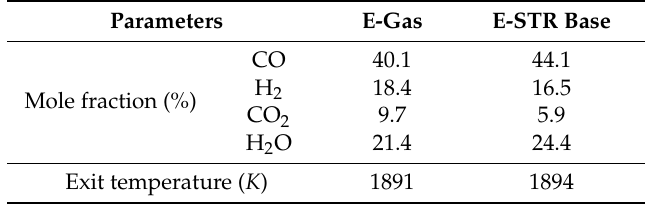
Table 7. Exit syngas compositions and temperature of benchmark E-STR case and